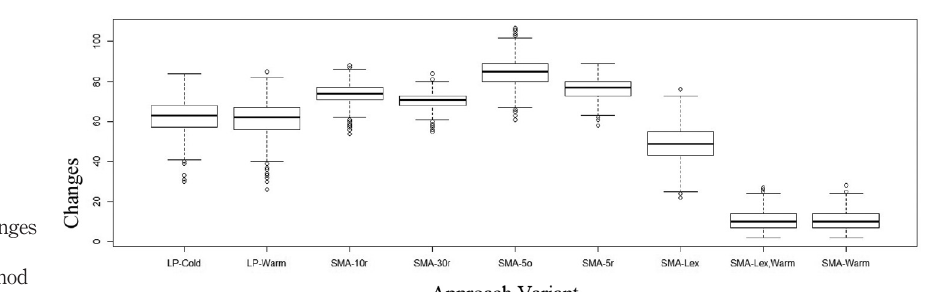
Figure 1. Percentage of of fi cers matched to a top- three preferred assignment